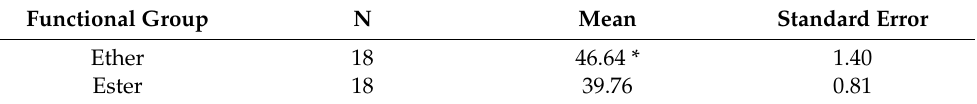
Table 5. Group statistics (FDI) (%) compared among functional groups of thymol derivatives. Functional